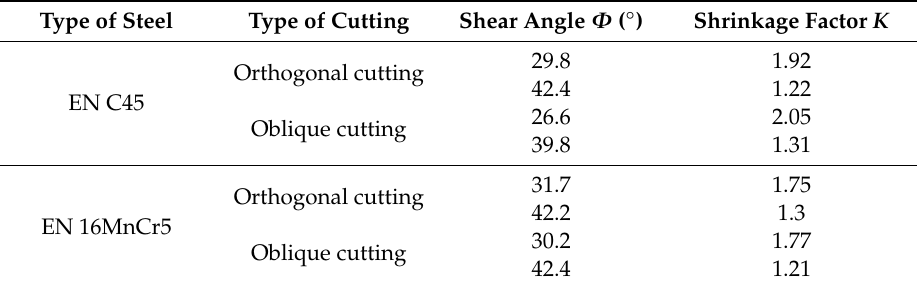
Table 9. Shrinkage factor K achieved within the experimental